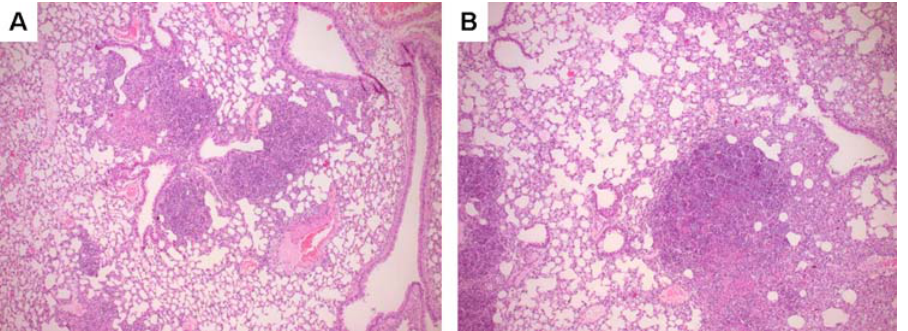
Figure 5. Pulmonary inflammation in mice infected with B.pseudomallei . Representative histopathology slides of lungs of WT (A) and MyD88 KO (B) mice infected with 5 6 10 2 CFU B. pseudomallei at 72 h after infection showing significant infilates, edema and peribronchial inflammation. The preparations were stained with haematoxylin and eosin. Original magnification, 6 50.